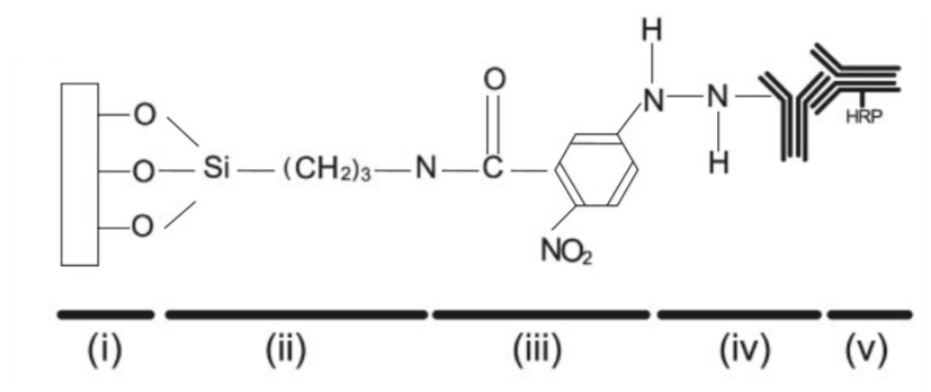
Figure 7. Schematic representation of a functionalized biosilica surface obtained by one of the methods described in Ref. [86]. ( i ) frustule surface; ( ii ) 3-aminopropyltrimethoxysilane (APS); ( iii ) N-5-azido-2-nitrobenzoyloxysuccinimide (ANB-NOS); ( iv ) primary antibody; ( v ) secondary antibody with horse radish peroxidase (HRP) conjugate. Adapted with permission from Ref. [86]. In Ref. [87] De Stefano et